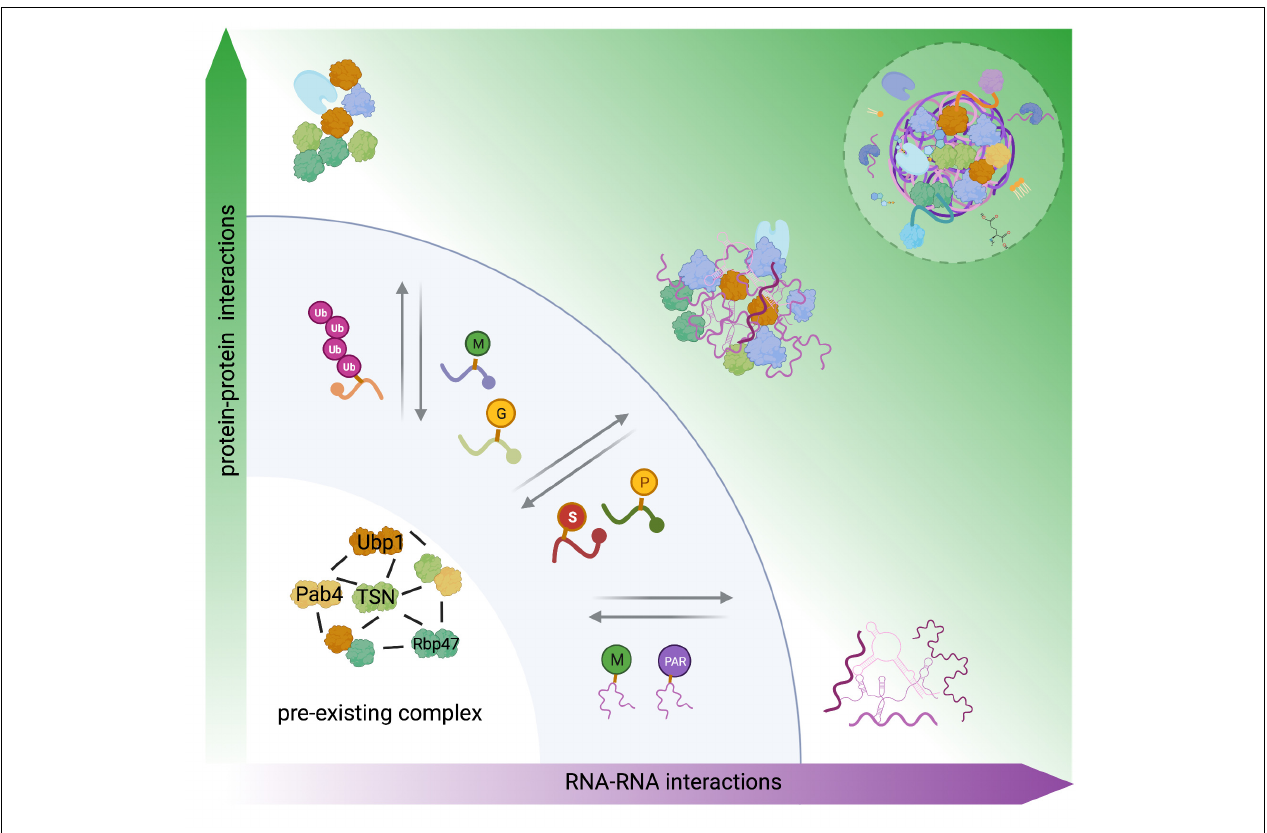
FIGURE 2 | Role of PTMs in the four-phase SG assembles model. SG nucleation assembly is described on the function of concentration and combination of either protein–protein, RNA–RNA interactions, or protein–RNA interactions. The evidence indicates the presence of preexisting complex under non-stress conditions. In line with this finding, we suggested this complex as a steady–ready interaction in the first step in the four-phase model, where PTMs and RNA modifications might function as a signal to regulate oligomerization, structure, subcellular localization, and protein functions, these evoked changes on SG components could modulate SG assembly or disassembly, independent of concentration. Modified from Van Treeck and Parker (2018). Created with